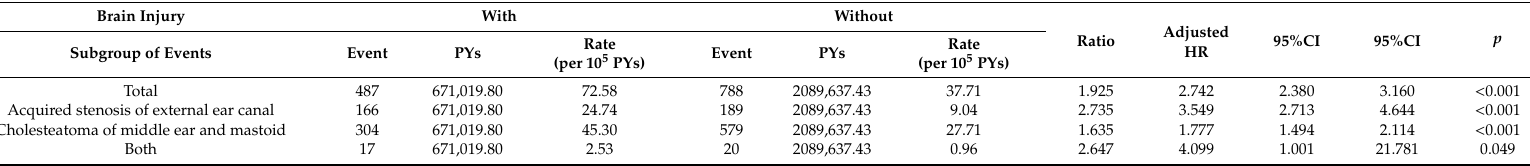
Table 4. Factors of acquired stenosis of external ear canal and cholesteatoma of middle ear and mastoid in the end of follow-up by using Cox regression. Brain Injury